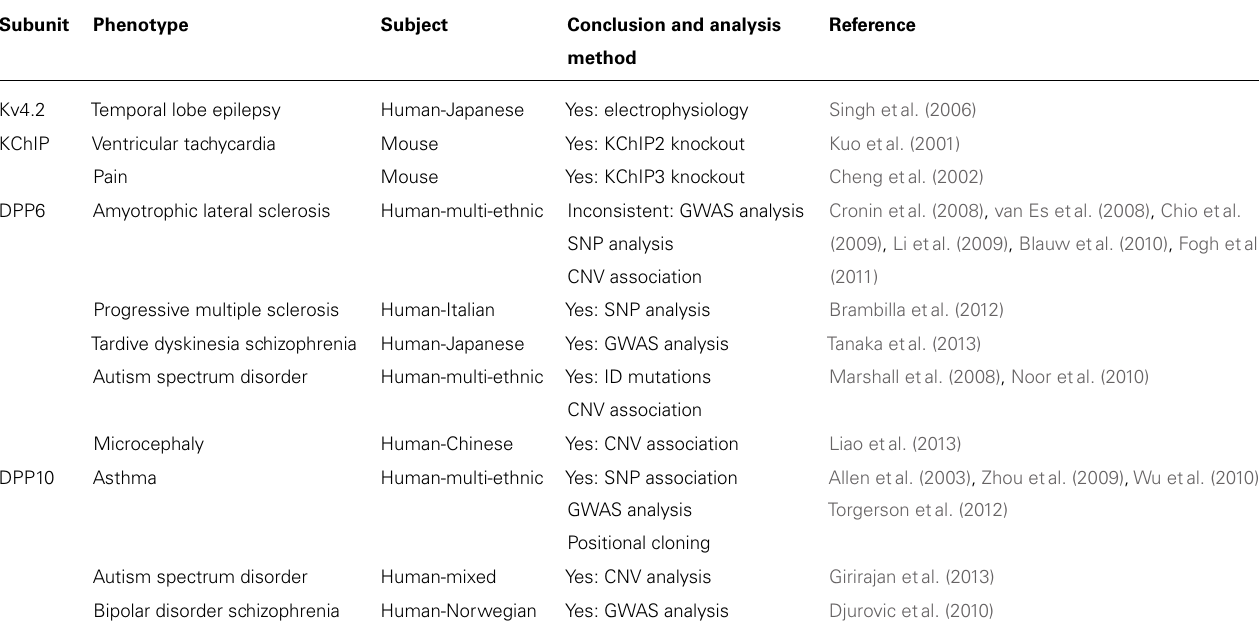
Table 2 | Genetic association between I SA subunits and disease/disorders. Subunit